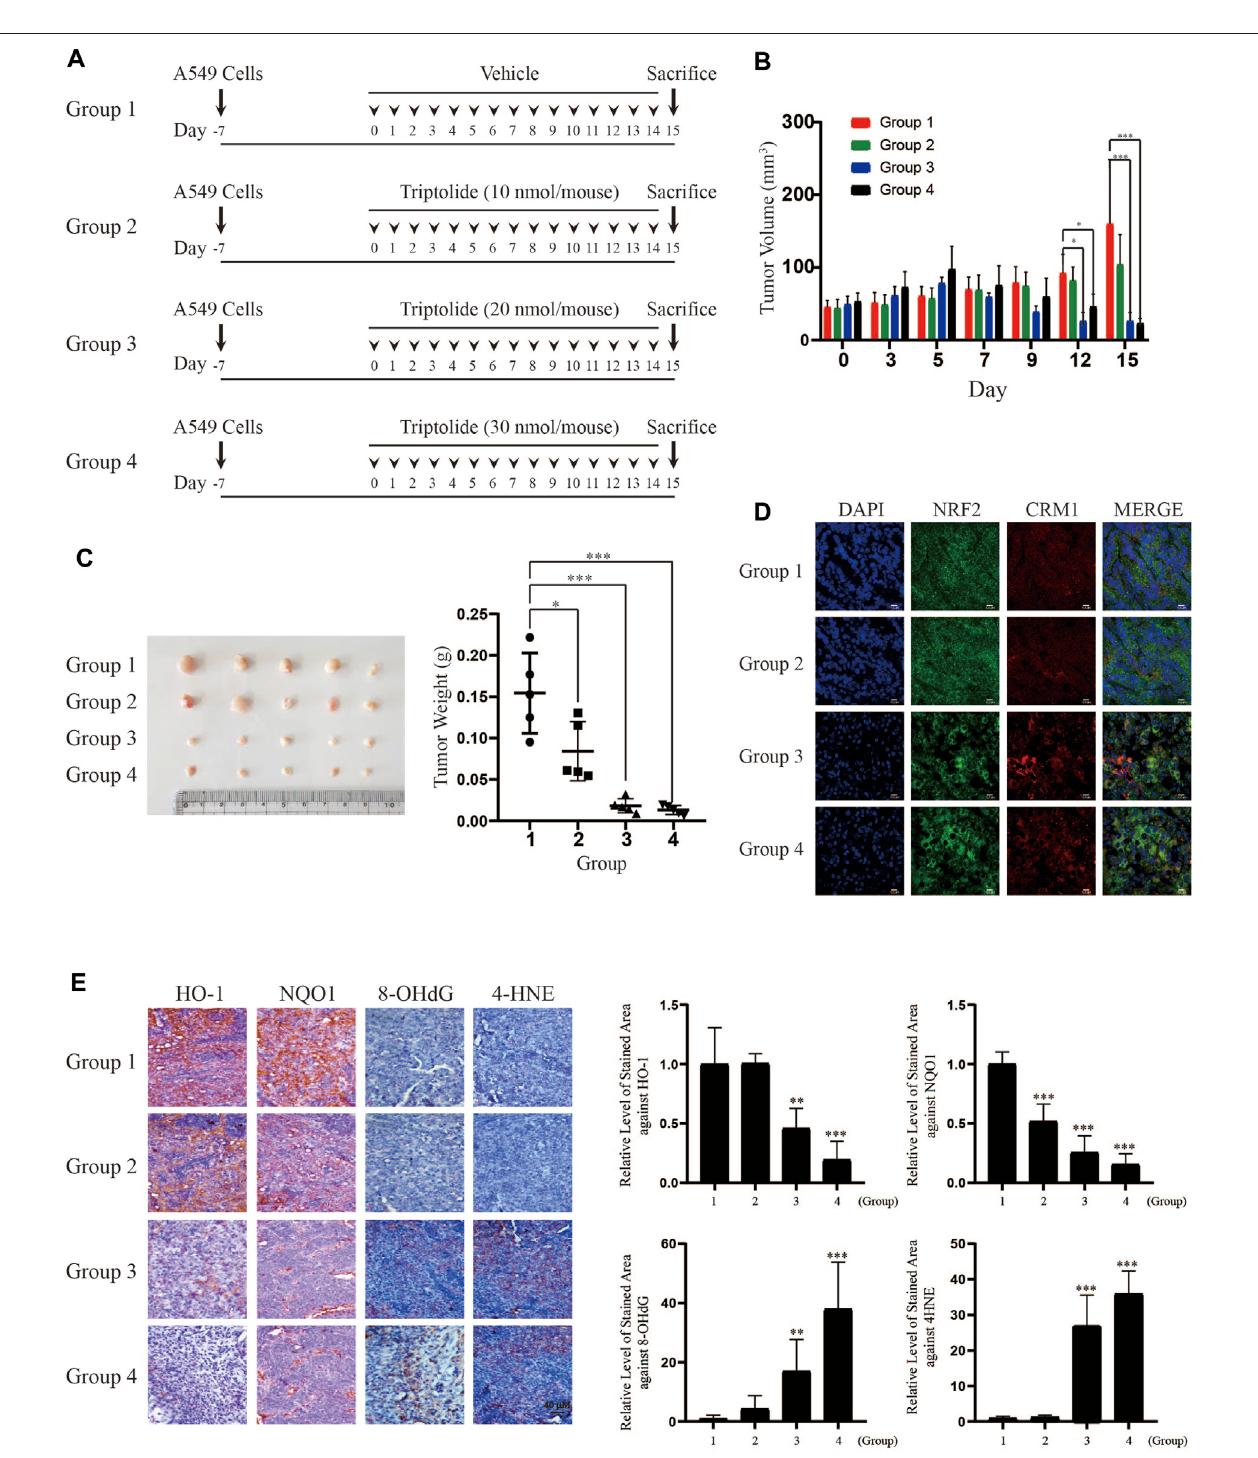
FIGURE 6 | Triptolide inhibits the growth of A549 xenografts in nude mice. (A) Experimental scheme of A549 xenograft experiment. (B) Triptolide suppresses the growth of A549 xenografts in nude mice. During the experiment, the volume of A549 xenografts was measured by caliper every 3 days and calculated based on the formula, V (cid:2) LxW 2 /2 (L: Length, W: Width). Asterisks indicate a statistical signi fi cance ( n (cid:2) 5): * p < 0.05 and *** p < 0.001. (C) Triptolide suppresses the weight of A549 xenograftsinnudemice.TheweightofA549xenograftswasmeasuredatsacri fi ce.Asterisksindicateastatisticalsigni fi cance( n (cid:2) 5):* p < 0.05and*** p < 0.001. (D) Triptolide promotes nuclear exclusion of NRF2 in vivo . Tissue samples of A549 xenografts were subjected to immuno fl uorescence using NRF2 and CRM1 antibodies. Representativeslidesofeach groupareprovided. (E) Triptolidesuppressestheexpression ofNRF2target proteins (HO-1andNQO1)and promotes oxidative stress(8- OHdG and 4-HNE) in vivo . The representative images of proteins stained with individual antibodies are provided (Left Panel) and the relative levels of stained area are provided (Right Panel). Asterisks indicate a statistical signi fi cance ( n (cid:2) 5): ** p < 0.01 and *** p < 0.001, compared with the control (Group 1).